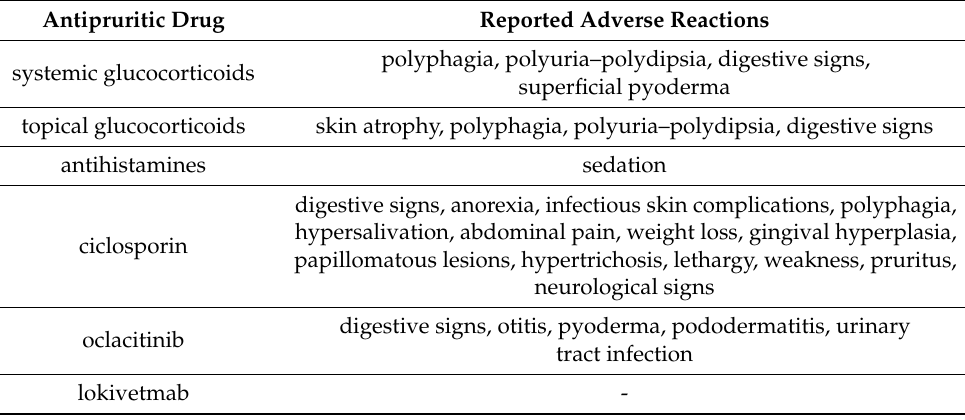
Table 2. Summary of adverse reactions reported in the literature with antipruritic drugs used in